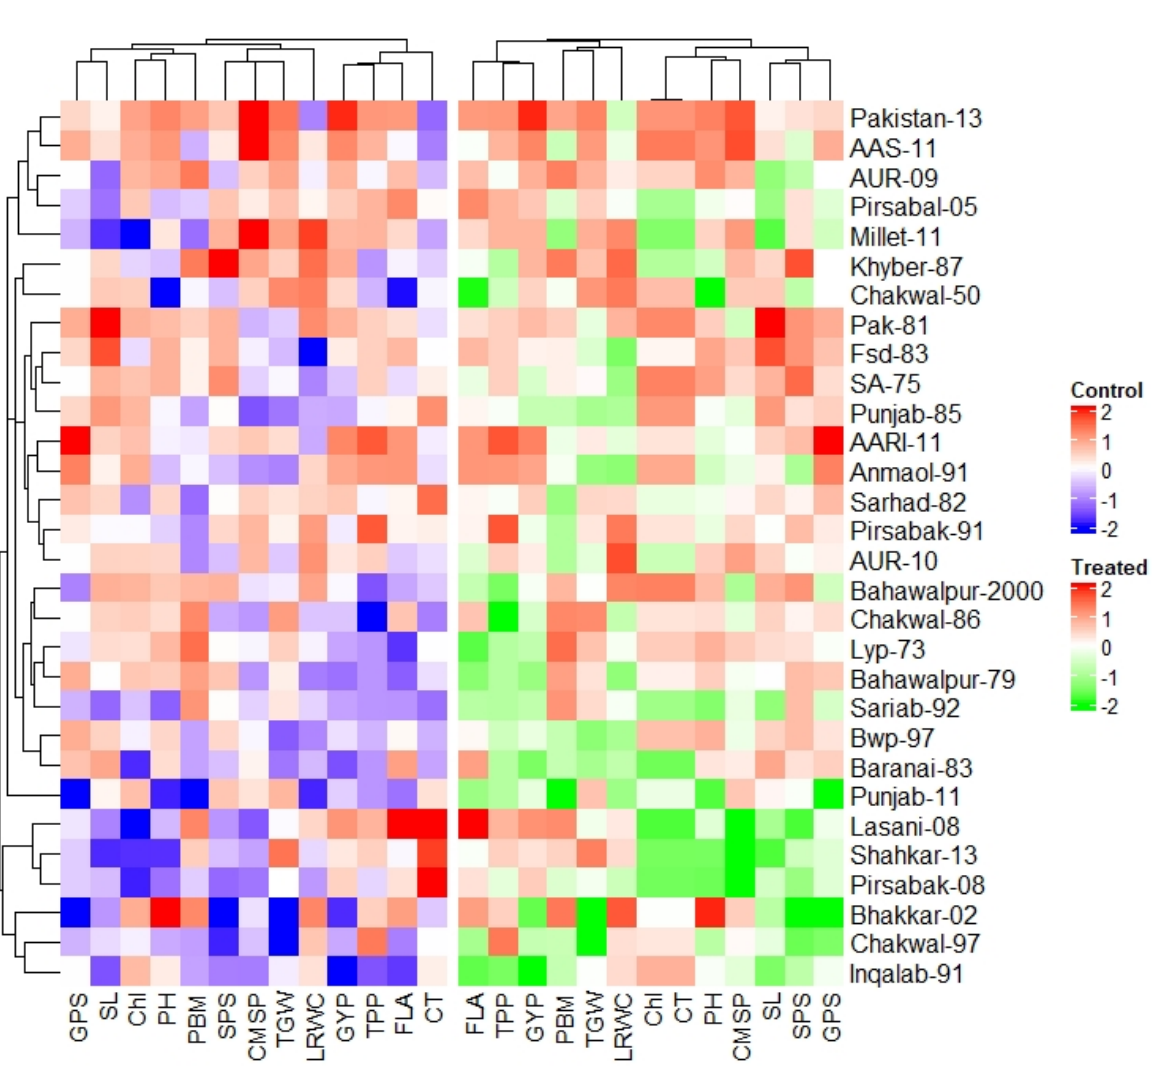
Figure 4. Heatmap dendrogram dividing wheat genotypes into different clusters based on the extent of association of physiological and agronomic traits under drought and control conditions. Chl, chlorophyll; CT, canopy temperature; CMPS, cell membrane percentage stability; LRWC, leaf relative water content; FLA, flag leaf area; PH, plant height; TPP, tillers plant − 1 ; SL, spike length; SPS, spikelet spike − 1 ; GPS, grains spike − 1 ; GYP, grain yield spike − 1 ; TGW, thousand grain weight; PBM, plant biomass.